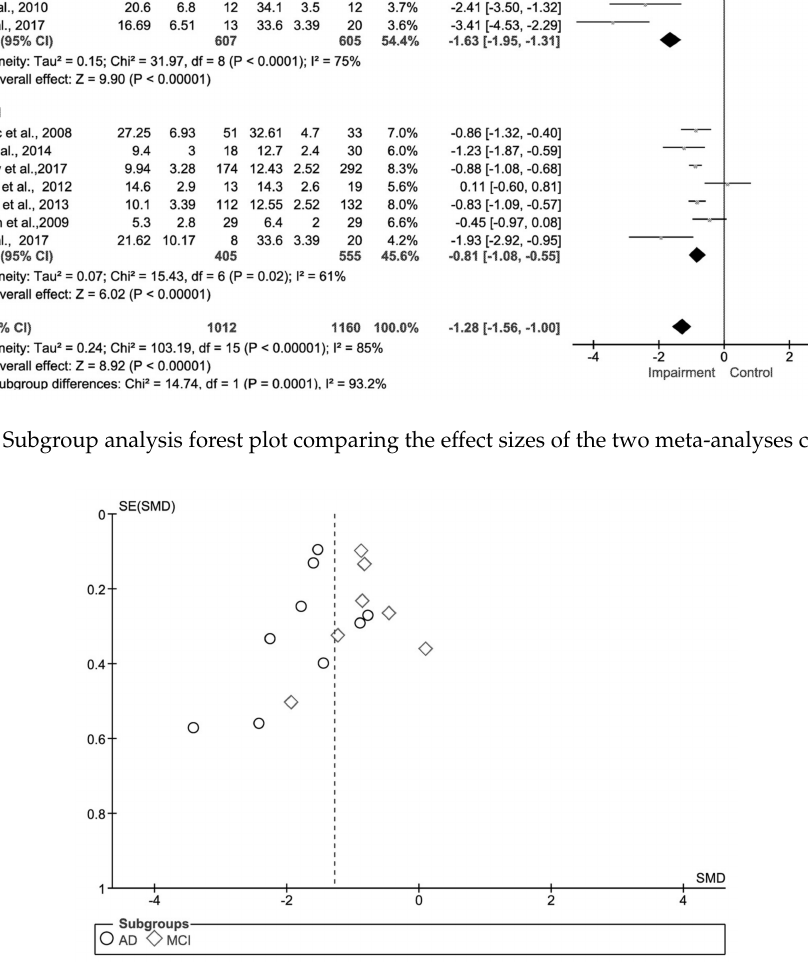
Figure 8. Funnel plot